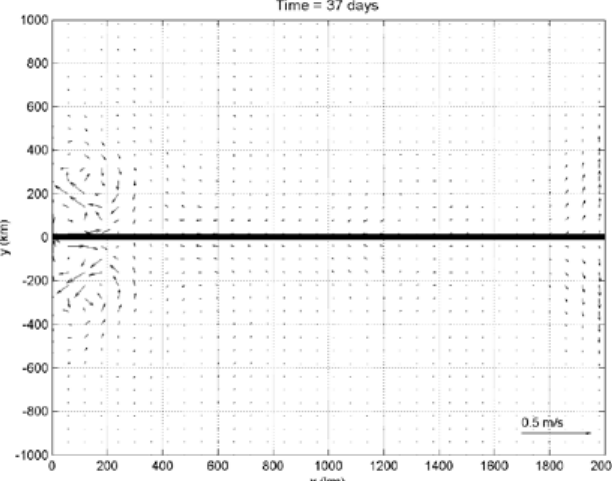
Fig. 2 : Currents plot on the 37th day of simulation